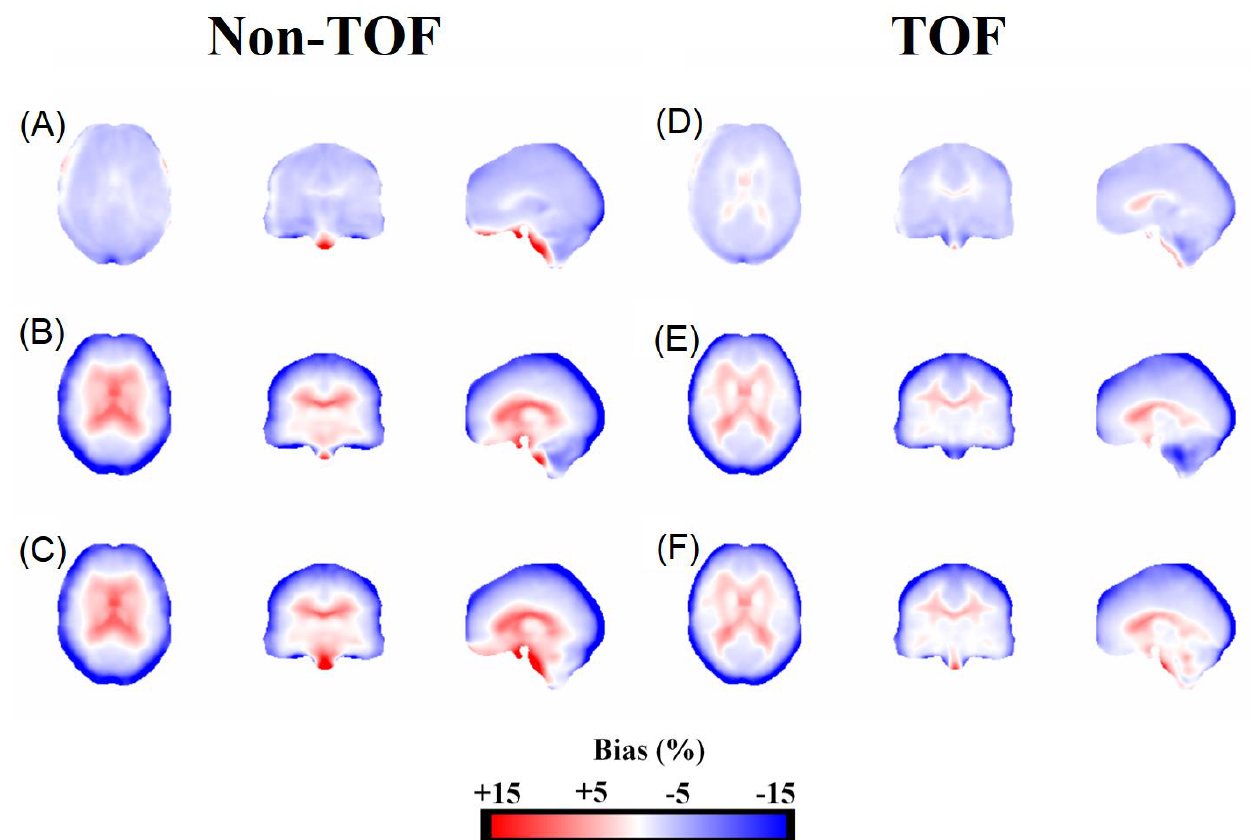
Figure 6. Mean bias atlas images from non−TOF and TOF reconstructed PET. A clear reduction of bias is seen in the TOF reconstructed images across the brain compared to non−TOF reconstructed PET. ( A ) 3−class MRAC, ( B ) 2−class MRAC, ( C ) 2−class MRAC without air cavities using non−TOF reconstruction. ( D ) 3−class MRAC, ( E ) 2−class MRAC, ( F ) 2−class MRAC without air cavities using TOF